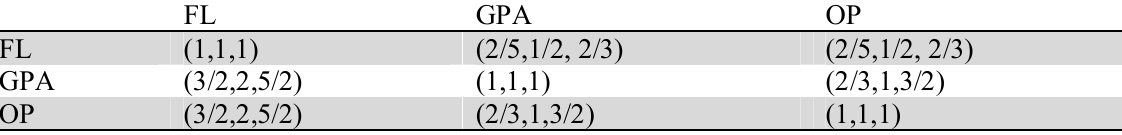
The Evaluation Matrix Relevant to the Individual